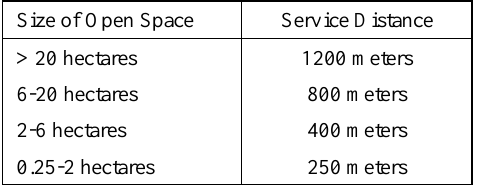
Table 5. The accessibility standard